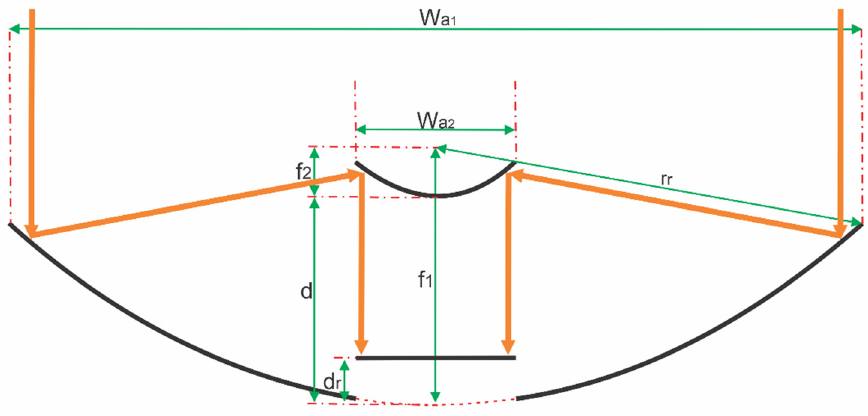
Figure 1. Geometry of the linear Cassegrain-type thermal photovoltaic concentrator.